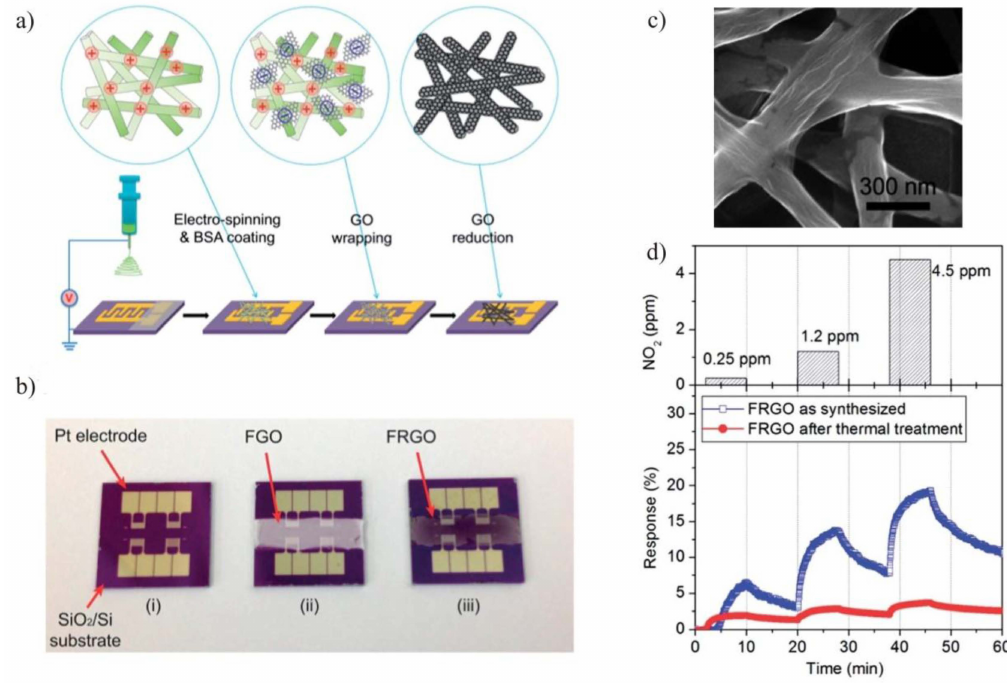
Figure 1. ( a ) Schematic representation of fabricating a gas sensor based on rGO/nylon-6 nanofibers; ( b ) Optical images of the bare device (i), GO/nylon-6 coated, formation of GO network based on interwoven fibers (FGO) (ii), and rGO/nylon-6 sensing device, rGO gas sensors fabricated on electrospun nanofibers (FRGO) (iii); ( c ) SEM image of rGO nanofiber; ( d ) Sensing response of the devices based on FRGO as synthesized (blue line) and thermally treated FRGO at 300 ˝ C (red line). {Reprinted with permission from [30], ©2014 Royal Society of